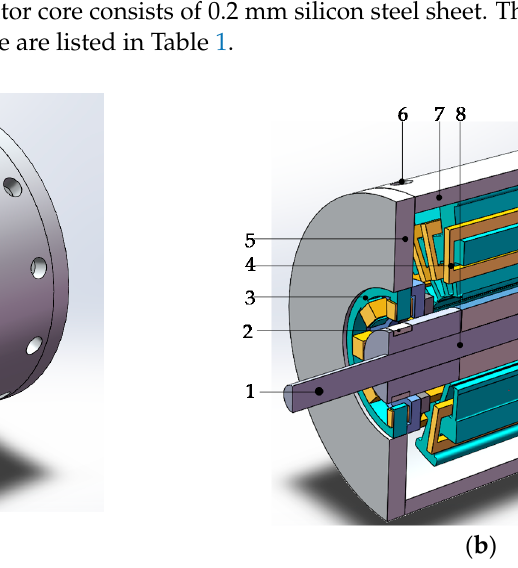
Figure 1. Motor structure: ( a ) Model; ( b ) Configuration of the high-speed PM motor: 1—Shaft; 2—Rotor of radial AMB; 3—Stator of radial AMB; 4—Motor stator; 5—Cover; 6—Outlet; 7—Shell; 8—Composite rotor; 9—Retaining sleeve; 10—Inlet; 11—Axial AMB; 12—Heat fin; 13—PM. Table 1. Parameters of HSPMSM.